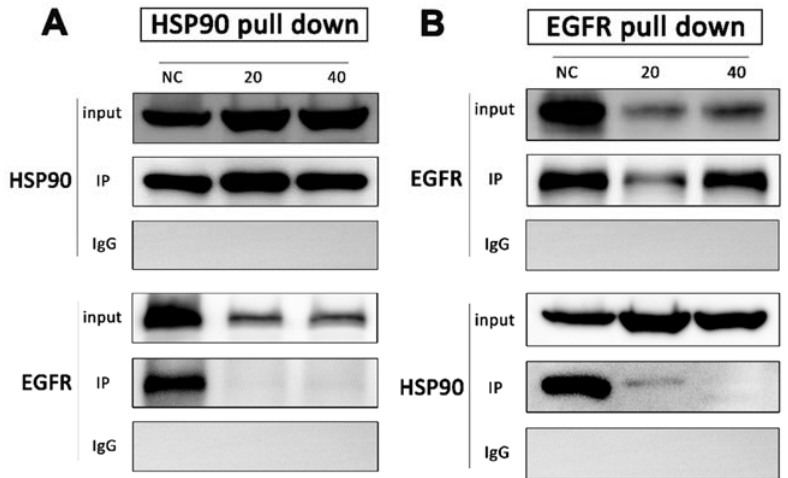
Figure 4. A375 cells were treated with DHP1808 for 24 h before lysis. ( A , B ) HSP90 and EGFR were immunoprecipitated from the lysates, respectively, and samples were analyzed by immunoblotting with anti ‐ HSP90 and anti ‐ EGFR antibodies.